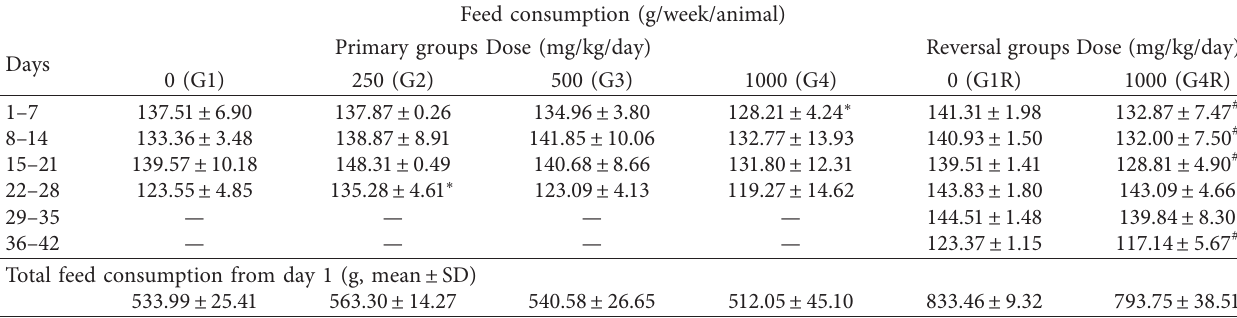
Table 1: Effect of oral administration of GMCT on feed consumption by male Wistar rats.